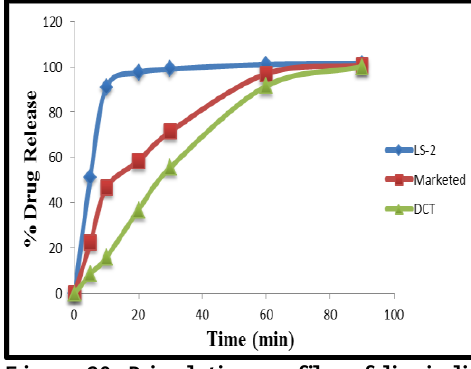
Figure 20. Dissolution profiles of liquisolid compacts LS-2, DCT and marketed tablets in 0.1N HCl (pH 1.2) at 37 ºC